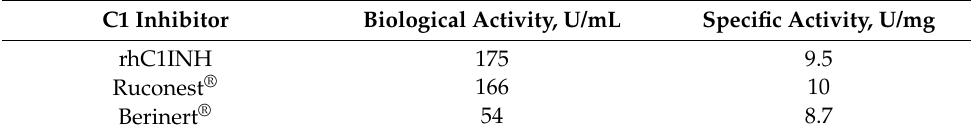
Table 8. Inhibition of C1s subunit by C1INH.